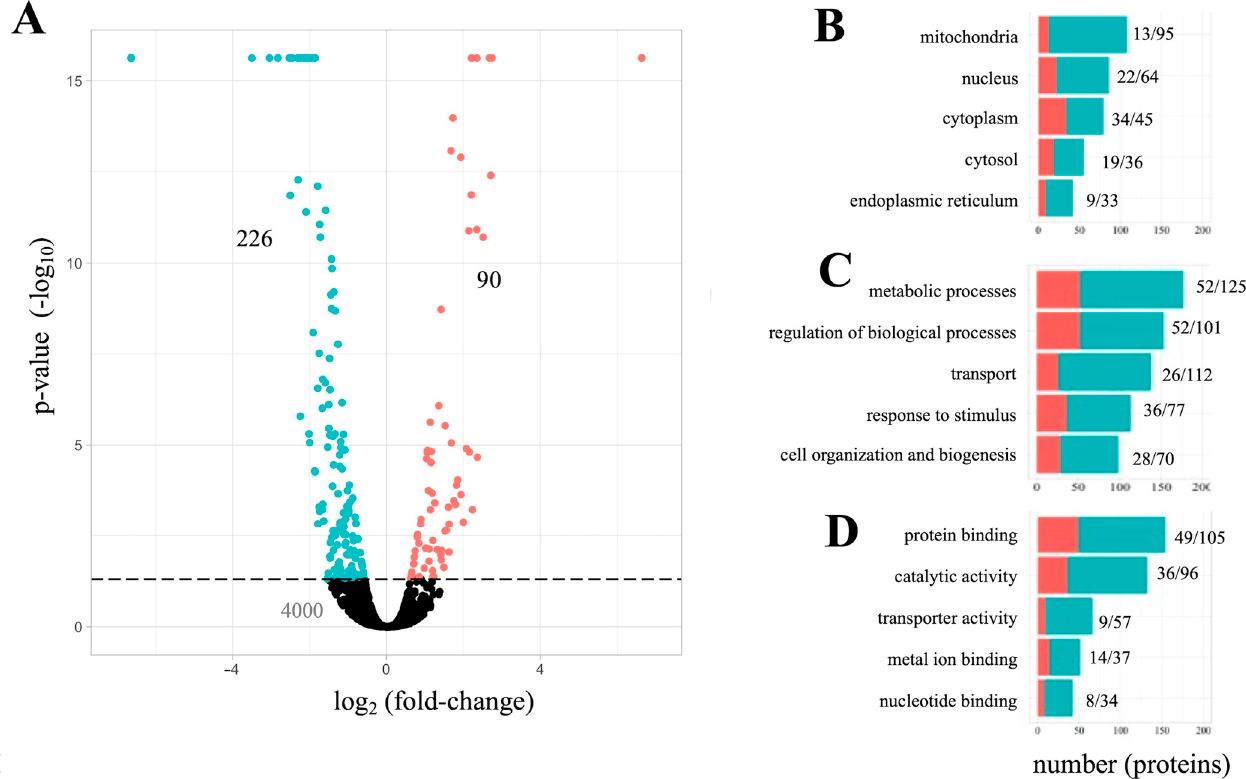
Figure 2. The A β 42 proteome and GO impacted process. ( A ) each point on the plot represents 1 of 4206 identified proteins. The dotted line indicates the threshold of statistical significance ( − log10 p -value). Green: 226 decreased proteins; red: 90 increased proteins. ( B – D ) the total number of significantly impacted proteins per GO domain: cellular component ( B ); biological process ( C ); and molecular function ( D ).